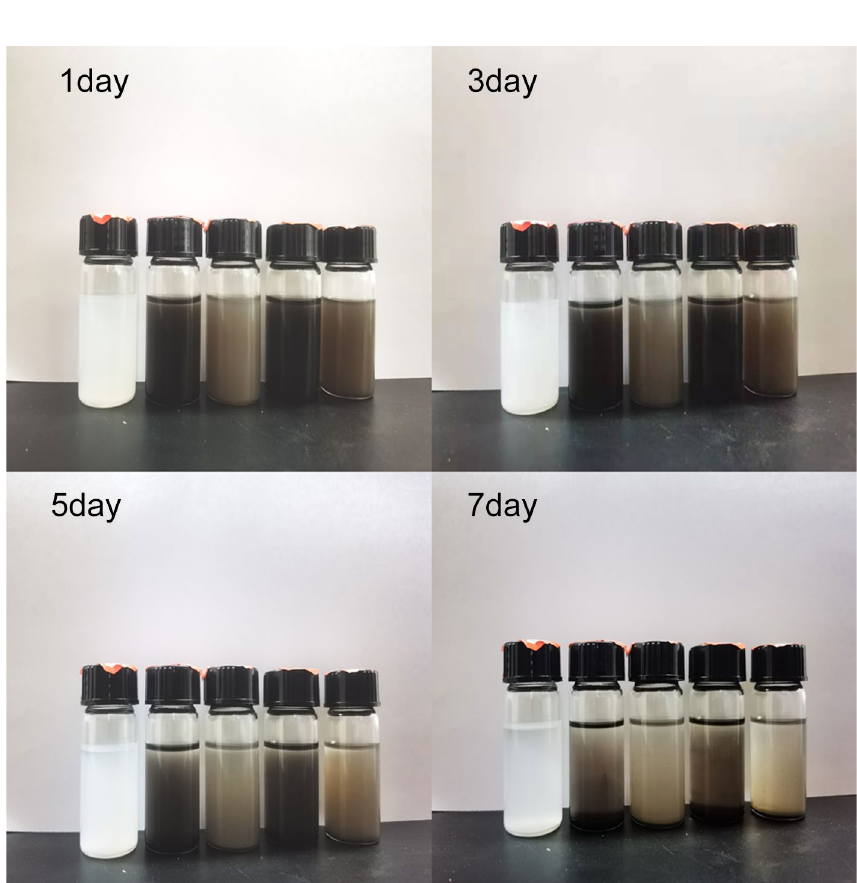
Fig.6 EDS analysis of CuO@BNNS